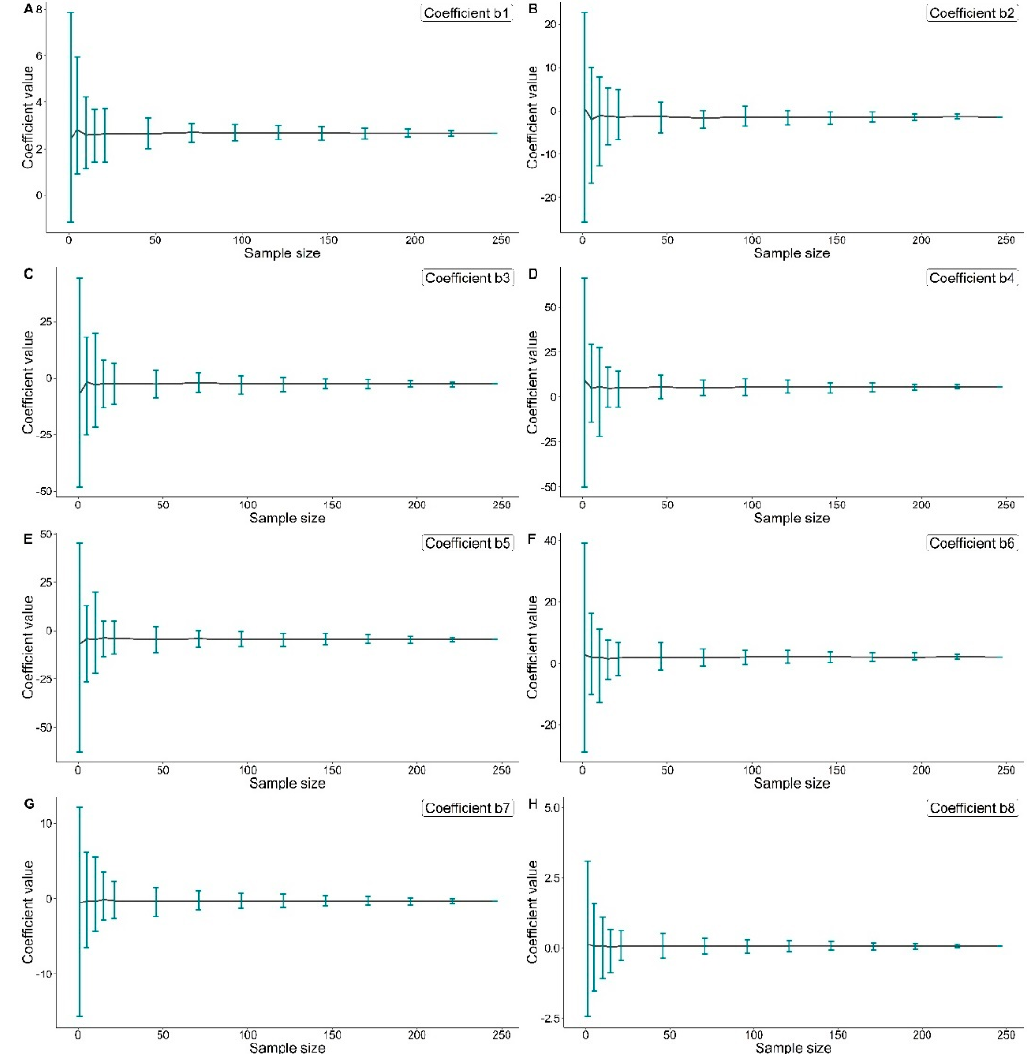
Figure 6. Range in coefficients of the taper curve equation developed with various sample sizes of Scots pines. A) Coefficient b1; B) Coefficient b2; C) Coefficient b3; D) Coefficient b4; E) Coefficient b5; F) Coefficient b6; G) Coefficient b7; H) Coefficient b8.